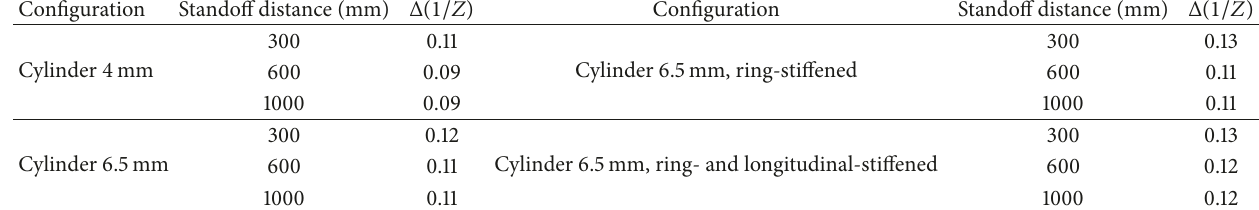
Table 7: Incremental values of IMs for different configurations and different standoff distances.